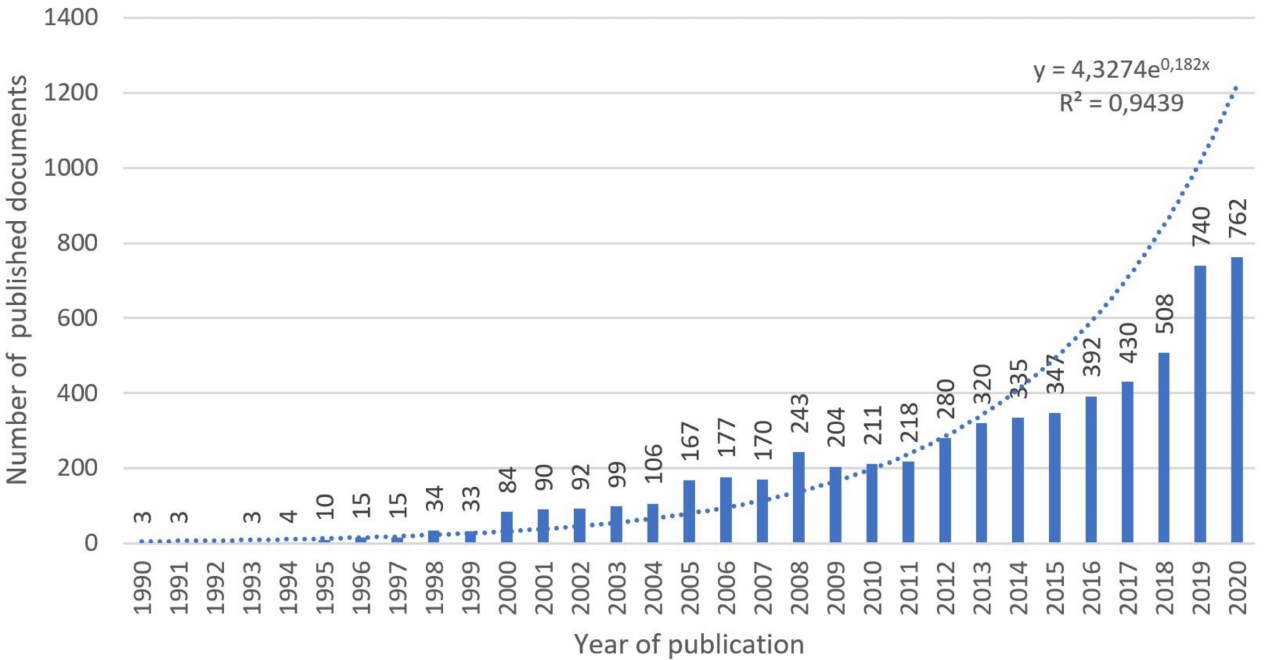
Figure 3. Publication trends of Scopus-based search literature on SCM.